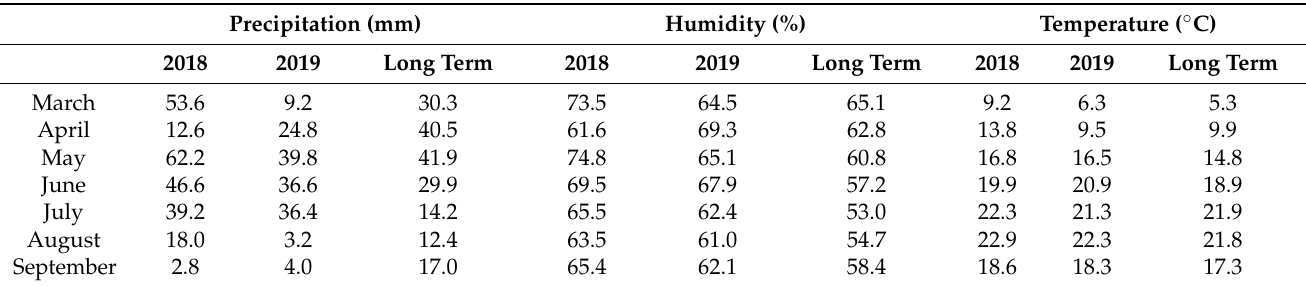
Table 6. Climatic data of research area in 2018 and 2019